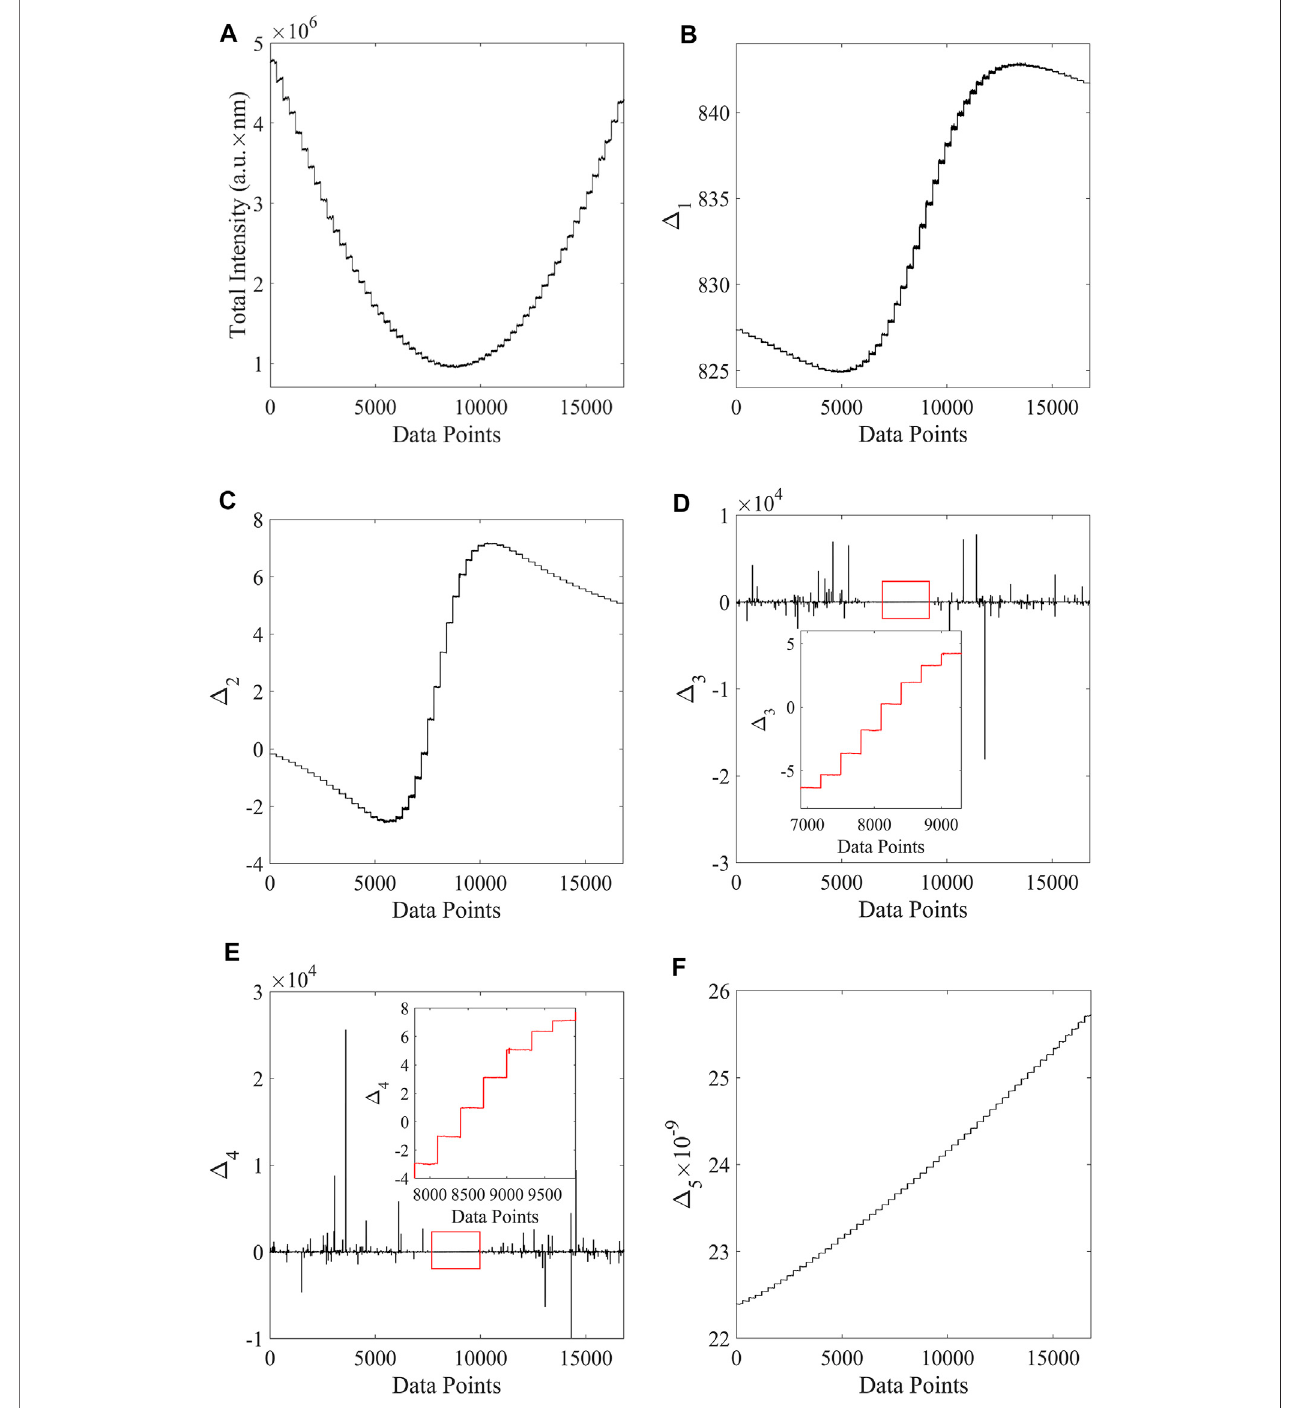
FIGURE 3 | (A) Distribution of the spectral relative light intensity corresponding to different phases. (B – F) Offsets and phase diagrams corresponding to the fi ve different characterization methods A, B, C, D, (E)